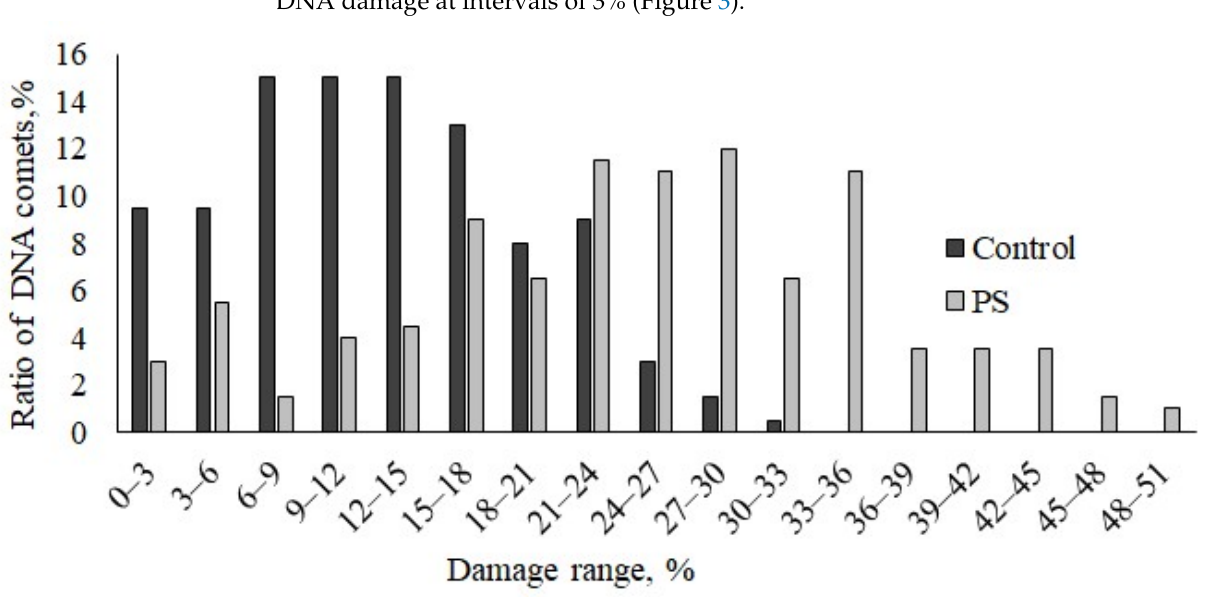
Figure 3. Distribution of DNA comets at 3% damage intervals in digestive gland cells (n = 12; n = 600).